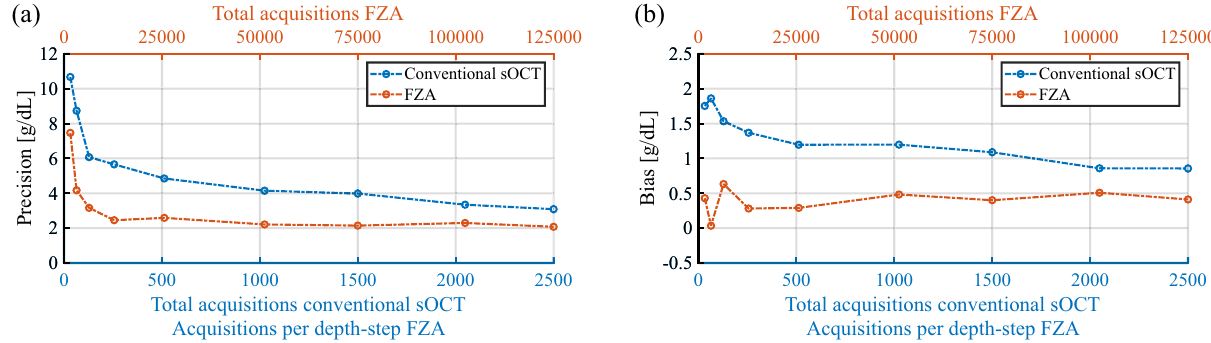
Figure 6. Precision (a) and bias (b) a function of acquisitions for conventional sOCT and FZA. For conventional sOCT, the precision and bias improve with increasing acquisitions. For FZA the precision and bias converge after 250 acquisitions per depth step (a total of 12, 500